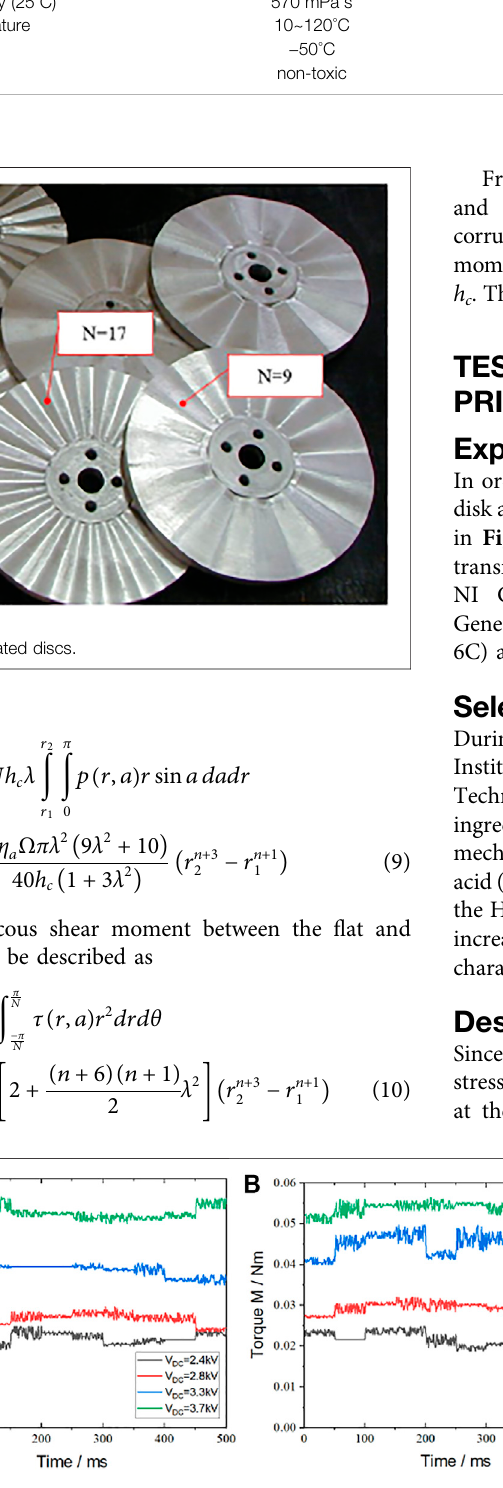
FIGURE 8 | The output torque curvesof ERF transmission with fl at discs. (A) Output torque under DC (B) Output torque under AC (C) the comparison of DC&AC.